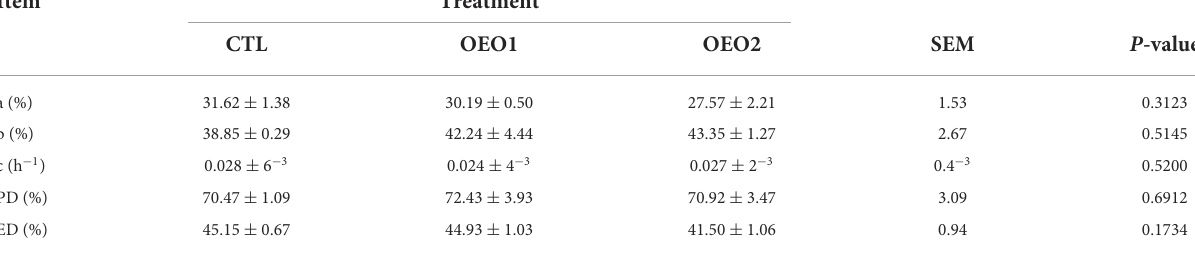
TABLE 5 Effect of orange essential oil (OEO) on in situ rumen degradation kinetics ( n = 6). Item Treatment